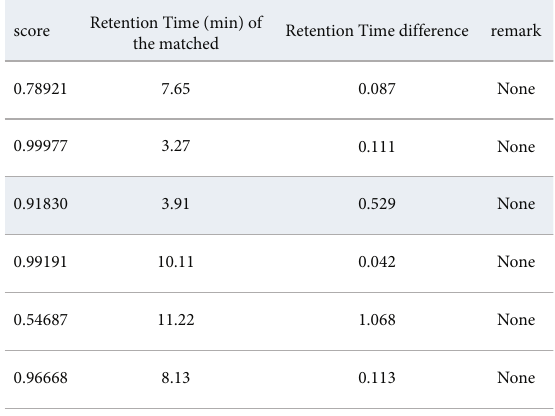
Figure 3: Screening results summary page (part